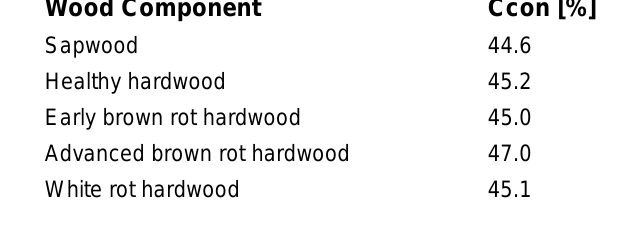
C Content of Wood Components with Different States of